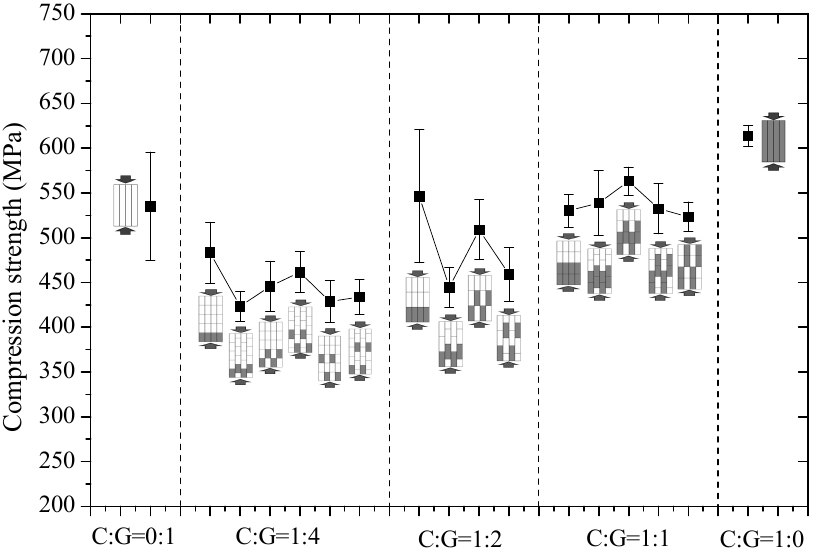
Figure 9. Compression strength comparison of different stacking sequences on various C/G ratios.